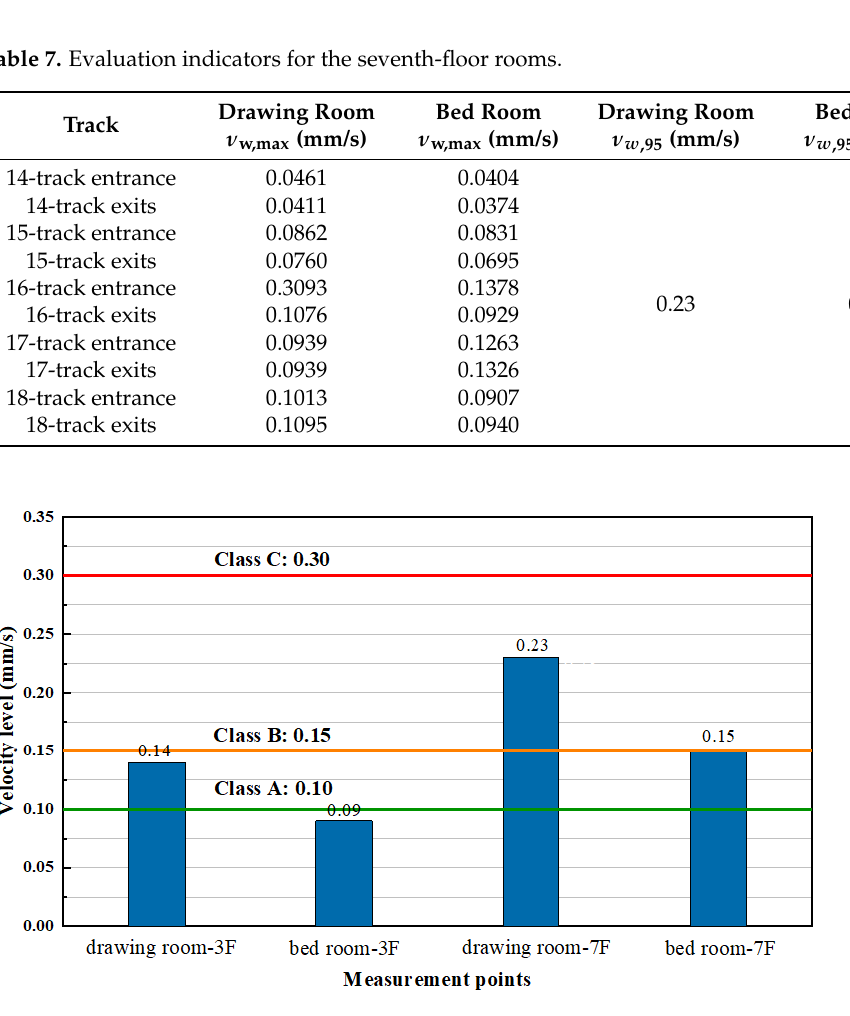
Figure 14. Comparison of vibration of the over-track building and Norway standard. Class A, normally not be expected to notice vibration; Class B, can be expected to be disturbed by vibration to some extent; Class C, about 15% of the affected persons in the dwellings can be expected to be disturbed by